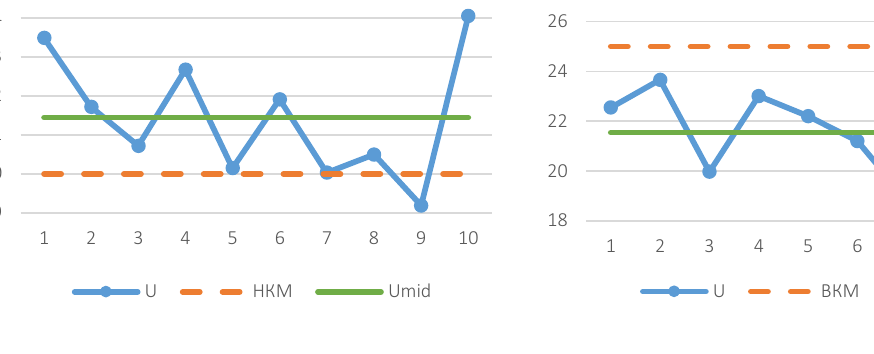
Figure 5. The Shewhart chart Figure 6. The Shewhart chart for the H7 (maximum credit risk per counterparty)